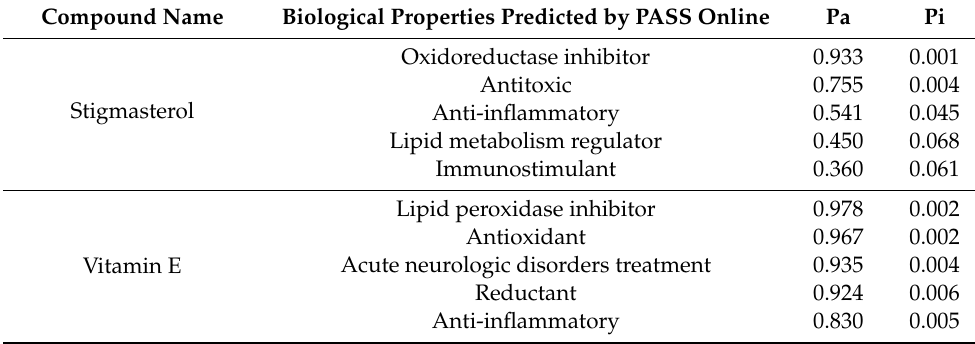
Table S1. Binding interactions of the identified compounds with potassium channel (pdb: 4UUJ) and human serotonin receptor (pdb: 5I6X) for anxiolytic and antidepressant activity respectively. Best ranked poses and 2D interactions of β -Sitosterol acetate, vitamin E, α -Tocospiro A, 2-Pentadecanone, 6,10,14-trimethyl, elaidic acid, n -Hexadecanoic acid, hexadecanoic acid, methyl ester with human serotonin receptor (pdb: 5I6X) for antidepressant activity (Figures S1–S7). Best ranked poses and 2D interactions of α -Tocospiro A, β -Sitosterol acetate, stigmasterol, vitamin E, 2-Pentadecanone, 6,10,14-trimethyl, n -Hexadecanoic acid, hexadecanoic acid, methyl ester and elaidic acid, with potassium channel (pdb: 4UUJ) for anxiolytic activity (Figures S8–S15). Table S2. Binding interactions of the selected compounds against COX-1 and COX-2 enzymes for anti-inflammatory activity respectively. Best ranked poses and 2D interactions of elaidic acid, β -Sitosterol acetate, stigmasterol, campesterol, vitamin E, α -Tocospiro A, 2-Pentadecanone, 6,10,14-trimethyl, neophytadiene, hexadecanoic acid, methyl ester, n -Hexadecanoic acid with COX-1 (pdb: 2OYE) and COX-2 (pdb: 3HS5) enzymes for anti-inflammatory activity, respectively (Figures S16–S26). Table S3. Binding interactions of the identified compounds in MEHC with xanthine oxidoreductase (pdb: 1R4U) for antioxidant activity. Best ranked poses and 2D interactions of stigmasterol, campesterol, α -Tocospiro A, vitamin E, β -Sitosterol acetate, 2-Pentadecanone, 6,10,14-trimethyl, elaidic acid, neophytadiene, n -Hexadecanoic acid, hexadecanoic acid, methyl ester with xanthine oxidoreductase (pdb: 1R4U) for antioxidant activity, respectively (Figures